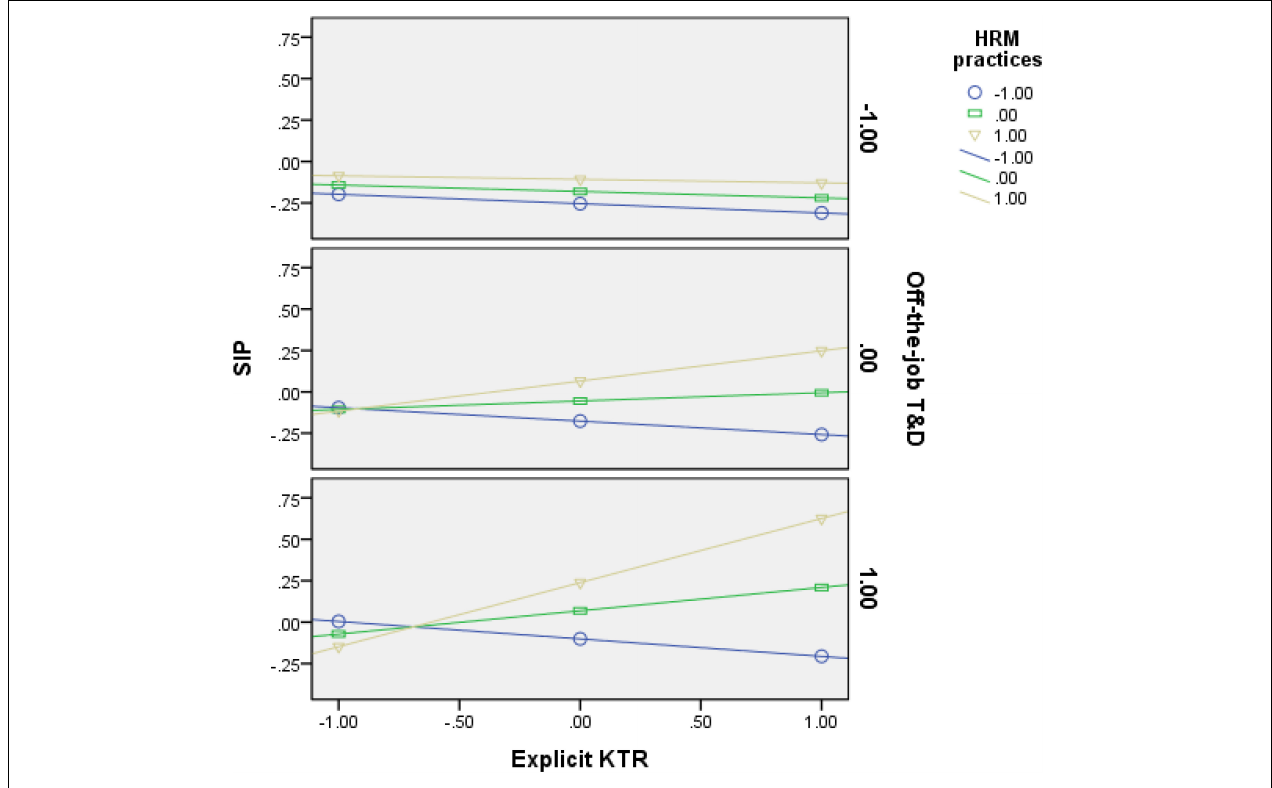
FIGURE 7 | The moderated moderation effects of off-the-job T&D on HRM practices, explicit KTR and SIP.